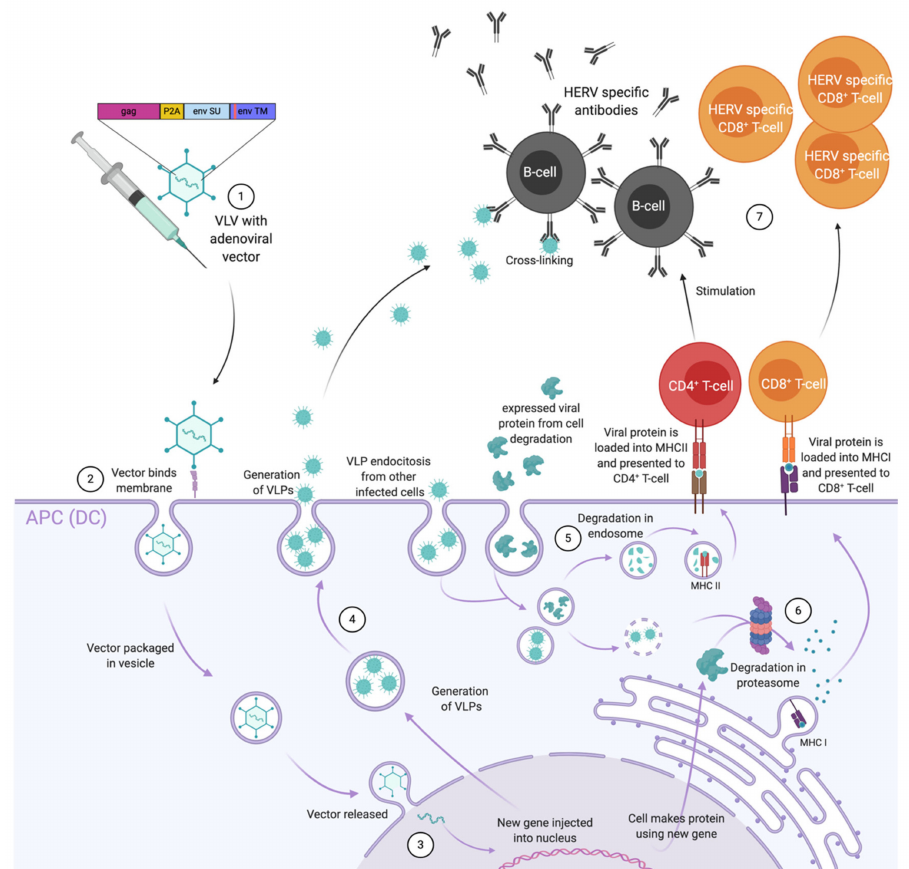
Figure 2. Illustration of the immune responses elicited by adenovirus based virus-like-vaccine (VLV) vaccination encoding endogenous retroviral (ERV) genes. (1) Vaccination with the adenoviral vector (Ad) encoding GAG and ENV genes, ideally harbouring mutations in the immunosuppressive domain (ISD) domain of ENV , is injected. (2) At the site of injection Ad directly infects professional antigen presenting cells (APCs) and releases the transgene into the recipient cell nucleus. (3) In the nucleus, the viral DNA codes for both viral and transgene proteins. Following their production, the fate of these proteins can be: (4) release of virus-like-particles (VLP)s to stimulate B-cells in an antigen structure dependent way; (5) uptake by APCs for endosomal degradation, presentation on major histocompatibility complex class II molecules (MHC-II), or (6) degradation in the proteasome (directly or after uptake) for presentation on major histocompatibility complex class I molecules (MHC-I) (7) stimulation of CD4 + T-cells and subsequent B-cell stimulation, and stimulation of CD8 +